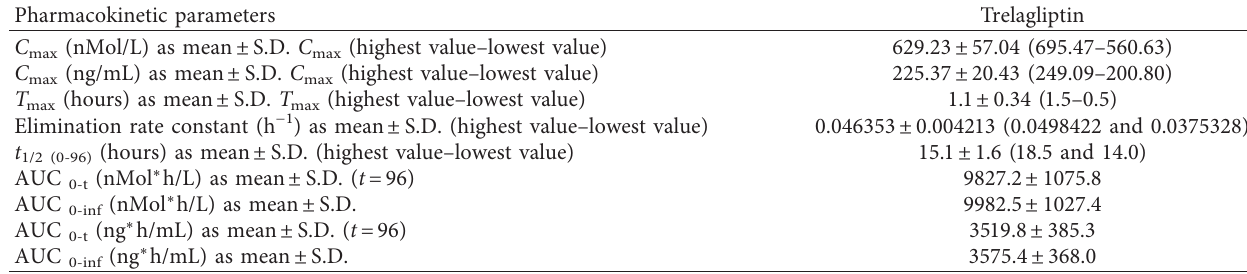
Table 2: Pharmacokinetic parameters of 50mg TLN after administration to healthy Egyptian volunteers ( n � 6). Pharmacokinetic